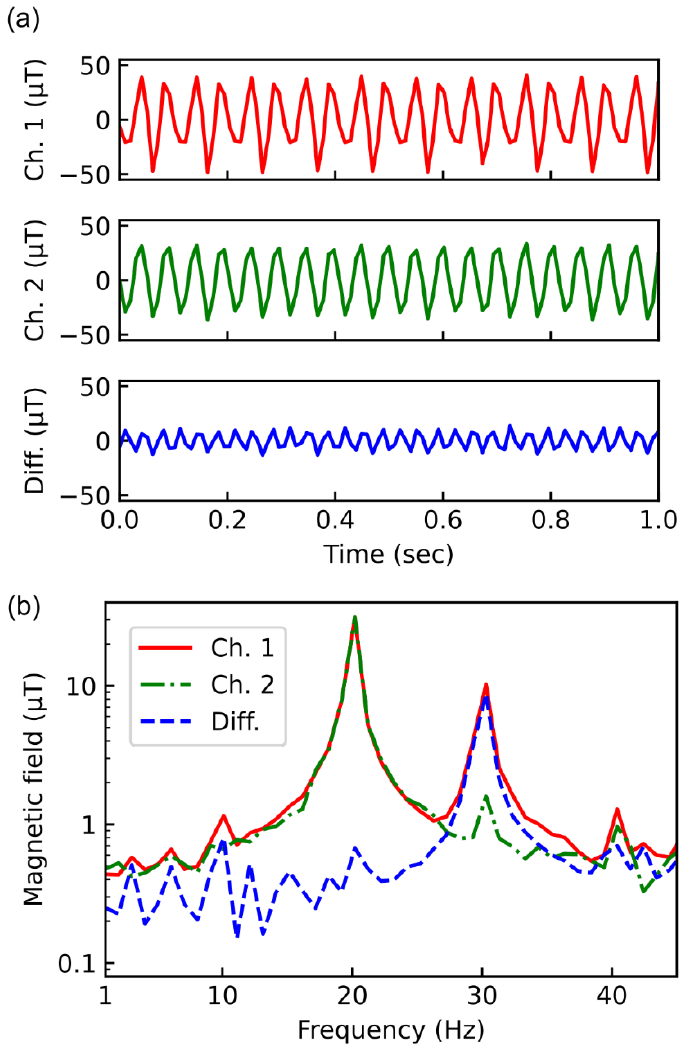
Figure 5. ( a ) Time-domain signals at sensor 1 (Ch.1), sensor 2 (Ch.2) and subtracted signal (Diff.). The detected wave for Ch. 2 is almost a single frequency wave because the copper wire applying a magnetic field of 30 Hz is far from sensor 2. On the other hand, since sensor 1 detects both 20 and 30 Hz magnetic fields, the detected wave at Ch.1 is a combination of the sin wave. ( b ) Fourier- transform of the time-domain signals from Ch.1 (solid red line), Ch. 2 (dashed-dotted green line) and diff (dashed blue